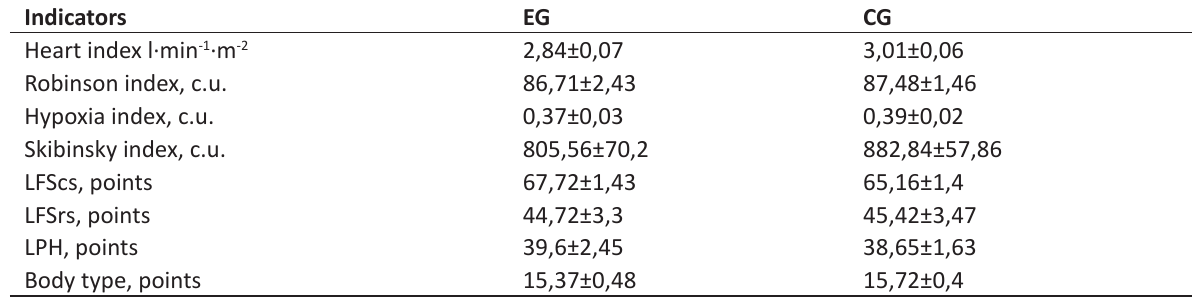
Table 2. Indicators of functional fitness at girls of experimental (EG) and control (KG) of groups to the forming experiment.